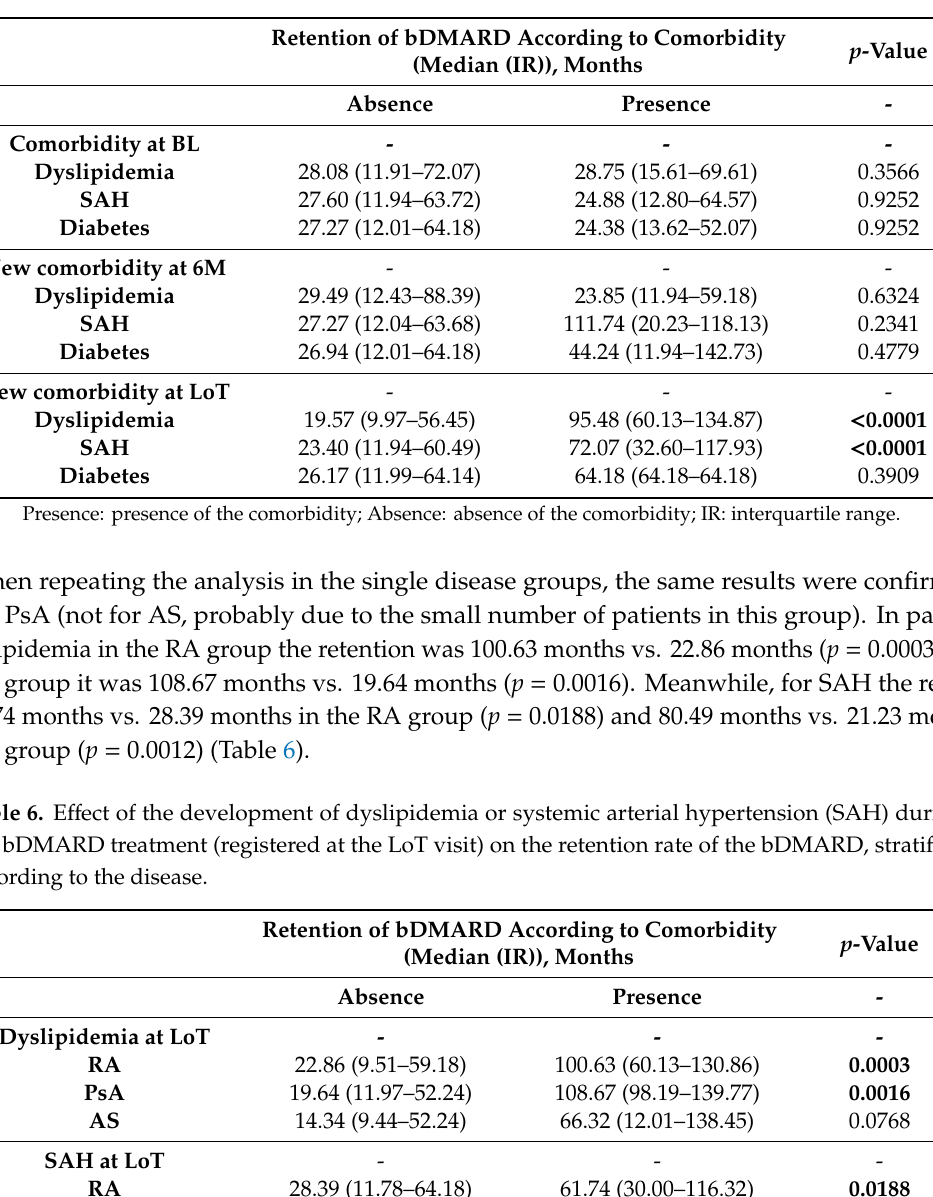
Table 5. E ff ect of comorbidities (present at BL or developed during treatment) on the retention rate of the bDMARD treatment.